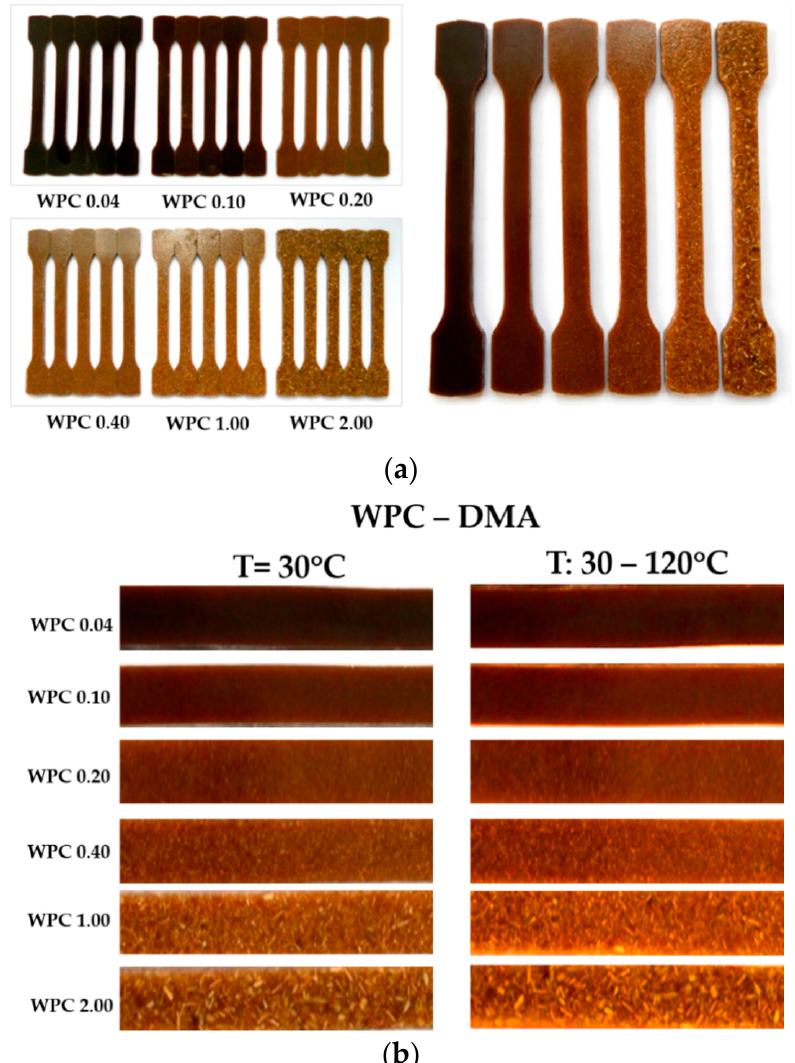
Figure 1. The specimens made from wood particles and polyester resin: ( a ) specimens for the tensile test; ( b ) samples for DMA. Table 1. The physical characteristics of samples for the tensile test.